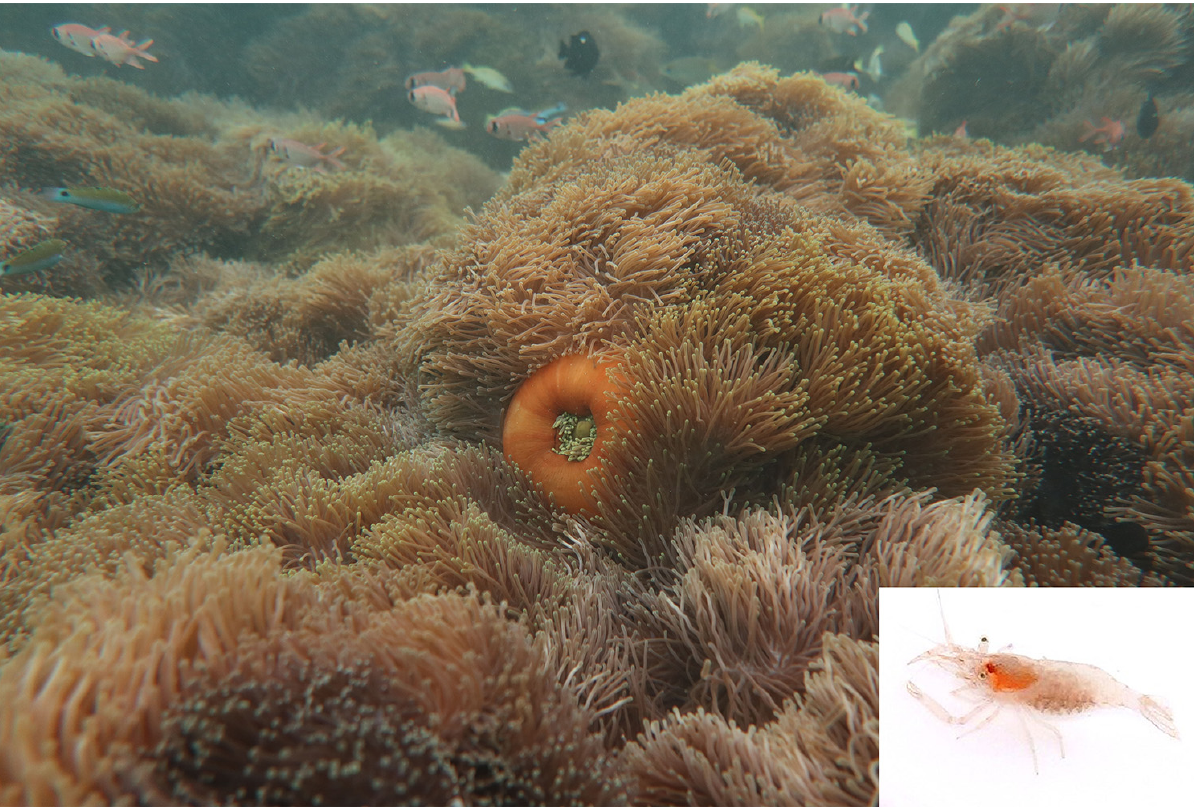
Figure 6. Collection site, assemblages of Heteractis magnifica at Agatti Island, Lakshadweep, India with live coloration of Actinimenes koyas sp. nov. (Depth 1 – 2